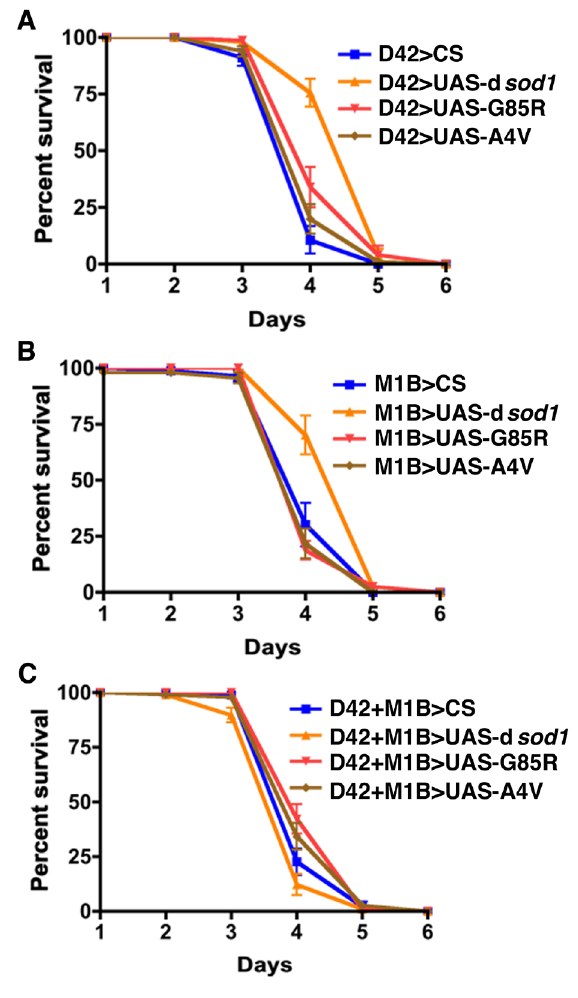
Figure 6. Effects of H O on SOD1 transgenic flies. Five day-old 2 2 male flies expressing SOD1 proteins in motor neurons ( A ), glial cells ( B ) and in motoneurons together with glial cells ( C ) were treated with 1% H O diluted in 3% sucrose. The results indicate an enhancing 2 2 effect of H O on mutant SOD1 toxiciy in MNs or glia when compared 2 2 to driver>UAS-d sod1 , but not to driver>CS control. Statistical analysis was performed using a two-tailed ANOVA method in Prizm software and was considered significant if p<0.05 (n=80–96 for each